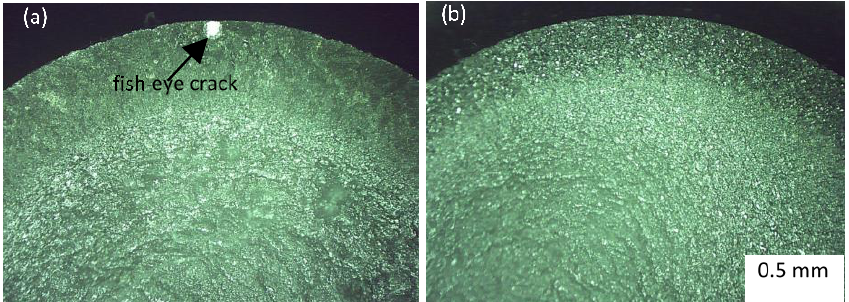
Figure 8. Fracture surface of ( a ) smooth and ( b ) notched specimens of vacuum-carburized and fine particle peened TM steel. ( a ): N f = 2.13 × 10 6 cycles, ( b ): N f = 2.41 × 10 6 cycles.